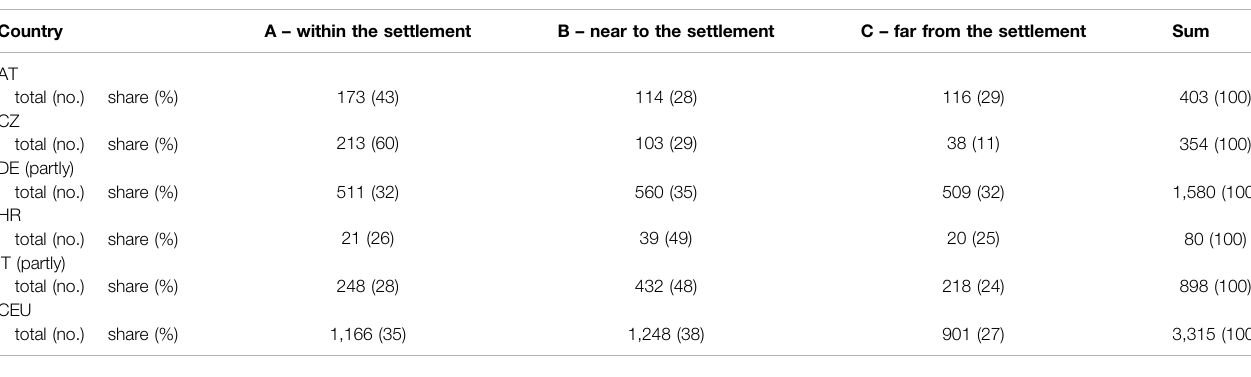
TABLE 6 | Spatial context of WWTPs for each country (own illustration). Country A – within the settlement B – near to the settlement C – far from the settlement Sum